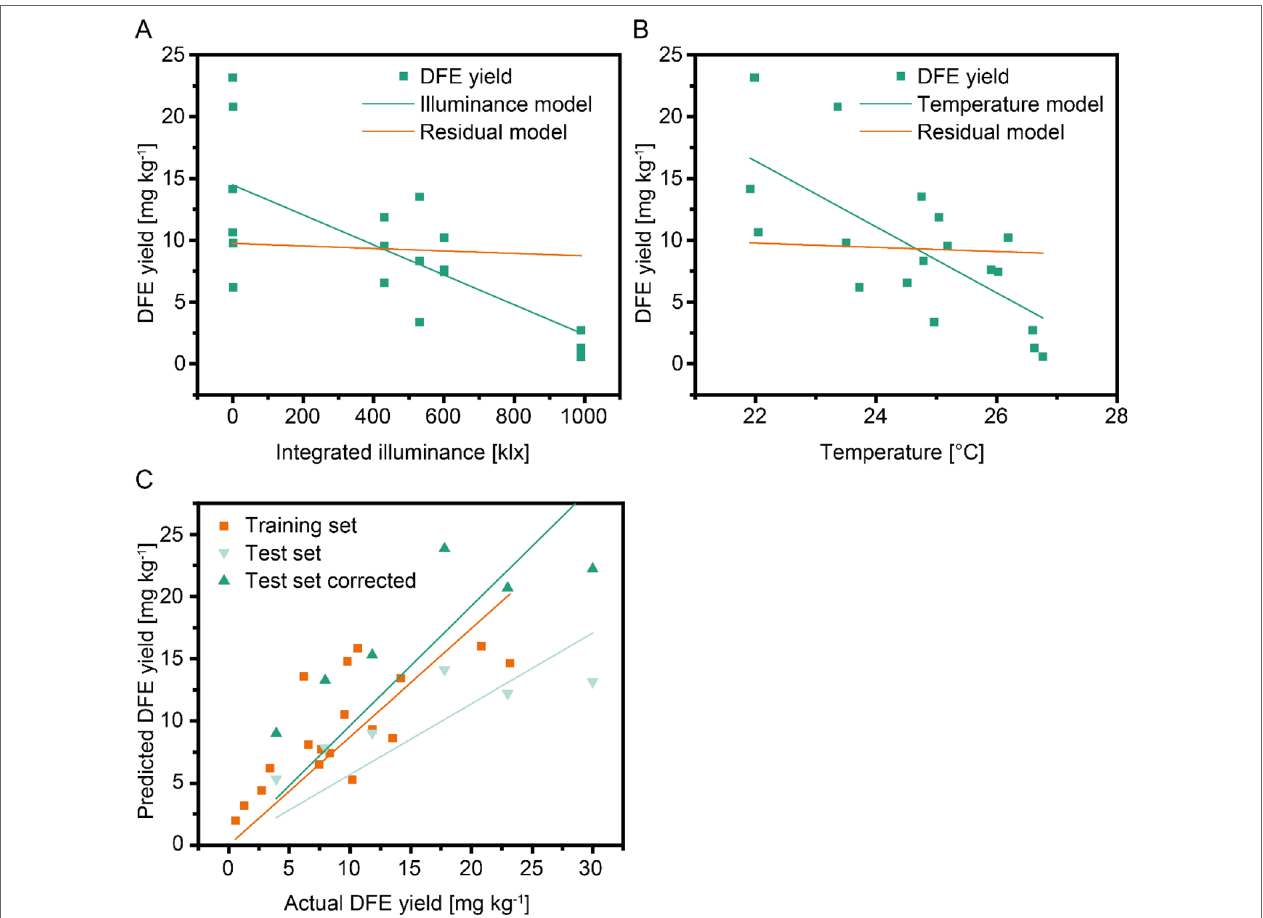
FIGURE 3 | Regression models for DFE yield using different weather factors and cultivation data. The effects of integrated illuminance (A) and temperature (B) as independent variables were intercorrelated. Green lines indicate the regression model, whereas orange lines correspond to a residual model with the effect of the independent variable removed. A multi linear regression model (C) based on integrated illuminance ≥45 klx and plant age showed a high correlation between training (second set of batches, orange line) and test (first set of batches) data. The prediction (light green line) improved substantially (dark green line) if a correlation factor of 1.69 was included in the model to compensate for differences in sample handling between the two sets of